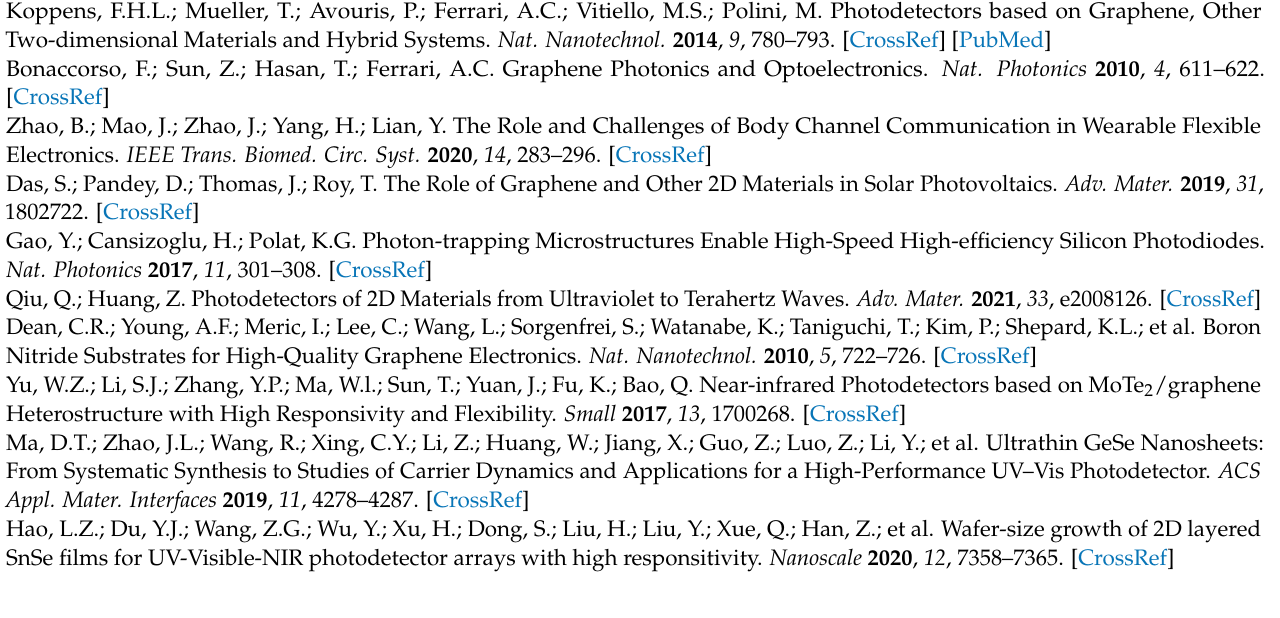
at different light power density with the wavelengths of ( a ) 532 nm, ( b ) 980 nm, and ( c ) 1550 nm; ( d ) Detectivity of the device as a function of laser power densities under different laser wavelengths. Figure S11: The photocurrent of pure graphene devices under four lasers. Figure S12: EDS results of the SnS nanoflakes. Figure S13: ( a ) The SEM image of the SnS nanoflakes FET. ( b ) The source − drain curves of the SnS nanoflakes FET were measured within the temperature range of 140 K to 300 K. Figure S14: ( a ) IV curves of SnS FET under dark and various wavelengths of light with different light intensities. The photoresponse of the device under ( b ) 375 nm, ( c ) 532 nm, ( d ) 980 nm, ( e ) 1550 nm, and ( f ) The current on − off ratio of SnS FET under different wavelengths. (V DS = 5 V). Figure S15: Transfer characteristic curves of the SnS nanoflake-based field-effect transistors at V DS = 0.1 V. Figure S16: The power-dependent and wavelength of rise/decay response of the SnS nanoflakes/graphene devices. Figure S17. Noise spectral density of 1/ f noise vs frequency at V DS = 1 V. Figure S18: The SEM images of different amounts of SnS nanoflakes by varying the weight of ( a ) 1.0 mg, ( b ) 2.5 mg, ( c ) 5.0 mg and ( d ) 10 mg of the SnS powders, scale bar: 10 µ m. ( e ) The photocurrent of the corre- sponding graphene-SnS nanoflakes heterostructure phototransistor. Figure S19: The photocurrent of another SnS nanoflakes/graphene devices under the laser of ( a ) 375 nm; ( b ) 532 nm; ( c ) 980 nm, and ( d ) 1550 nm. Figure S20: The HRTEM image of SnS NSs. Table S1: α and β were obtained by fitting the relationship between the ∆ V Dirac − P and R − P curves and the power function. Note S1: The calculation of photoconductive gain (G). Note S2: The calculation of